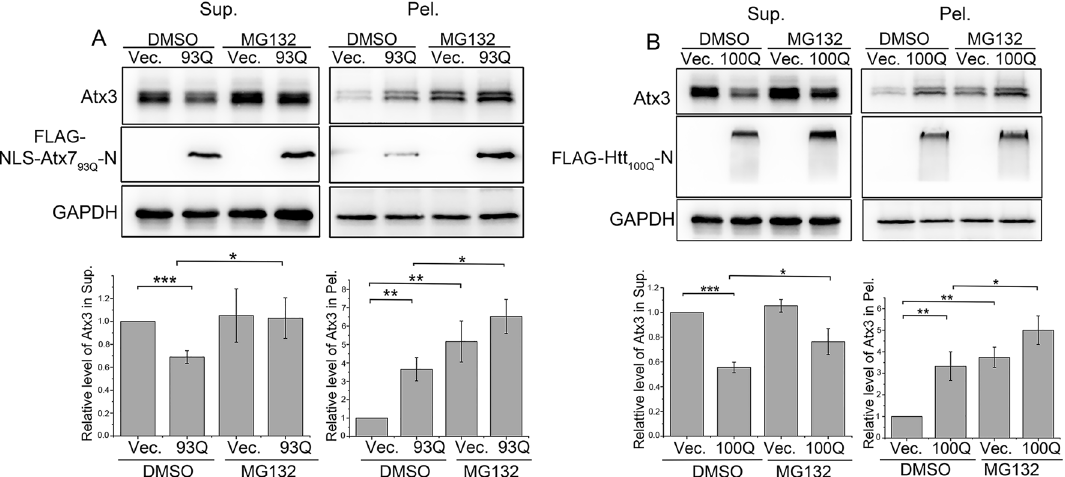
Figure 3. PQE Atx7 and Htt cause the reduction of soluble Atx3 through promoting proteasomal degradation. ( A ) Inhibition of proteasome suppresses the decline of soluble Atx3 caused by NLS-Atx7 93Q -N172. (B) As in (A), by Htt 100Q -N90. HEK 293T cells were transfected with each indicated plasmid and treated with MG132 (10 μM) for 12 h before harvest. DMSO was set as a control. The cell lysates were subjected to supernatant/pellet fractionation and Western blotting. Indicated proteins were detected by using anti-FLAG, anti-Atx3 and anti- GAPDH antibodies. Sup., supernatant; Pel., pellet. Data are shown as Means ± SEM (n = 3). * p < 0.05; ** p < 0.01; *** p <